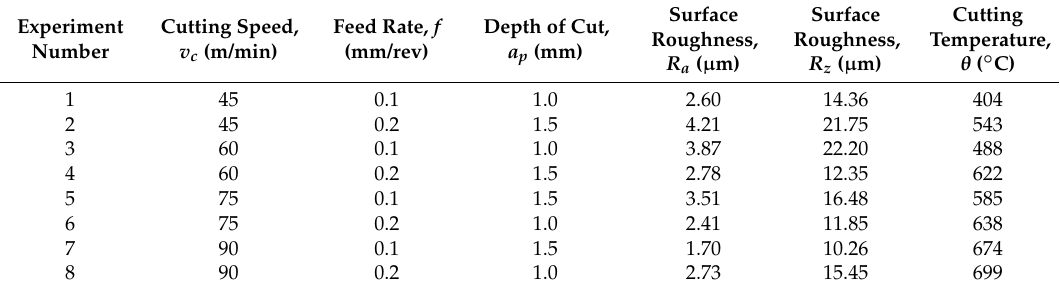
Table 1. Taguchi L8 orthogonal array and values of responses found from machining